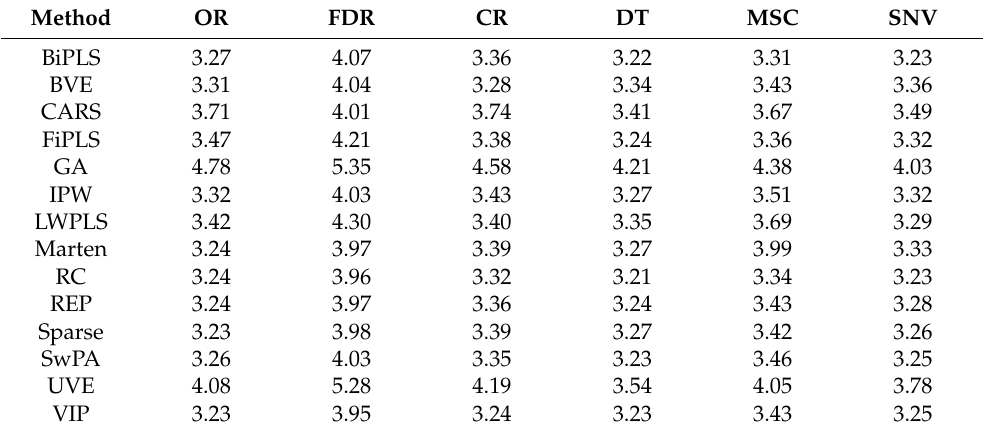
Table 4. Root mean square error (RMSE; µ g cm − 2 ) for each regression model (100